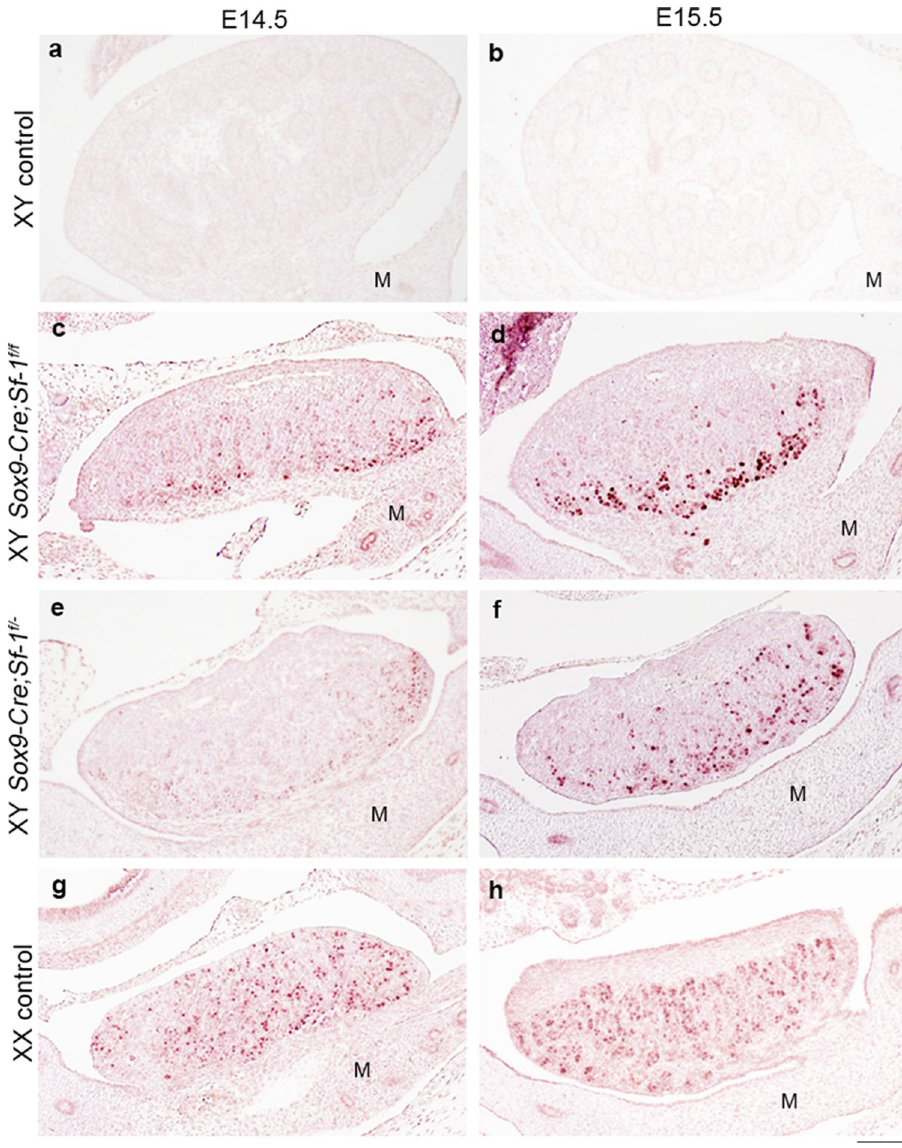
Figure 6. Presence of meiotic germ cells in XY Sox9-Cre - Nr5a1 cKO gonads. IHC for meiotic germ cell marker, STRA8, in gonads of XY control ( a , b ), Sox9-Cre;Nr5a1f. /f ( c , d ), XY Sox9-Cre;Nr5a1f. /− ( e , f ), and XX control ( g , h ) mice at E14.5 and E15.5 (left and right panels, respectively). Ventral, anterior, and posterior sides of gonad are upwards, right, and left, respectively. M, mesonephros. Scale bar, 100